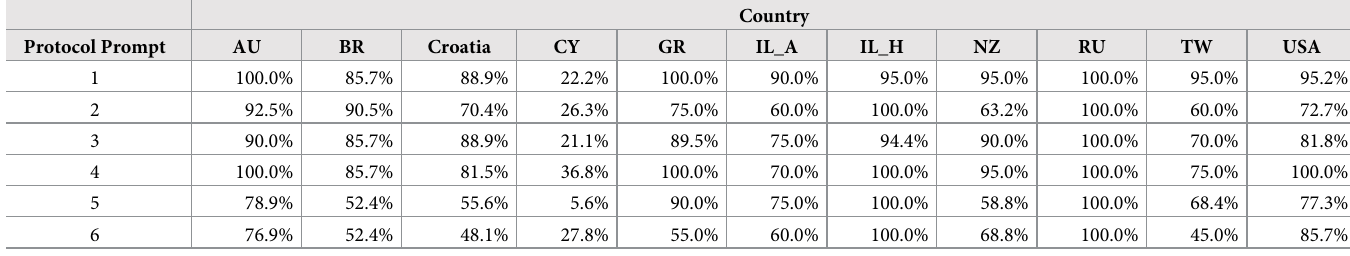
Table 4. Percentage of responses elicited without a scripted follow-up prompt, for each protocol prompt, by